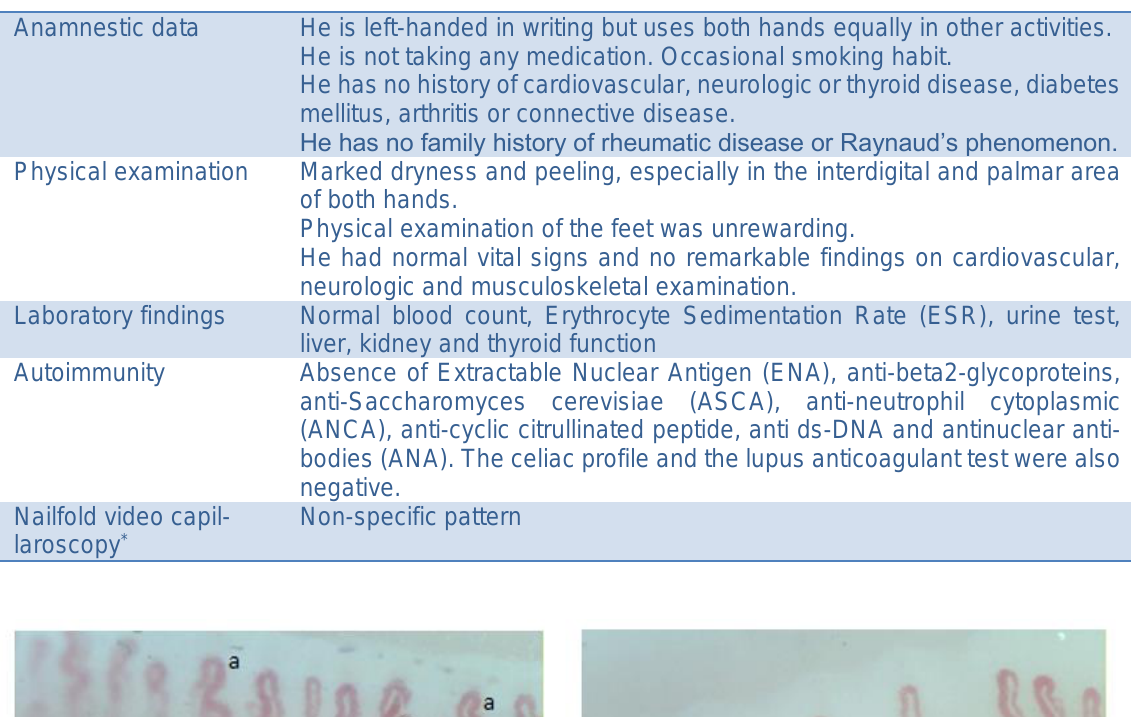
Table 1: Anamnestic, clinical and laboratory features of the patient. The NVC* was conducted using a ×200 optical probe with images being captured, coded and stored using a Videocap software (DS- Medica, Milano,